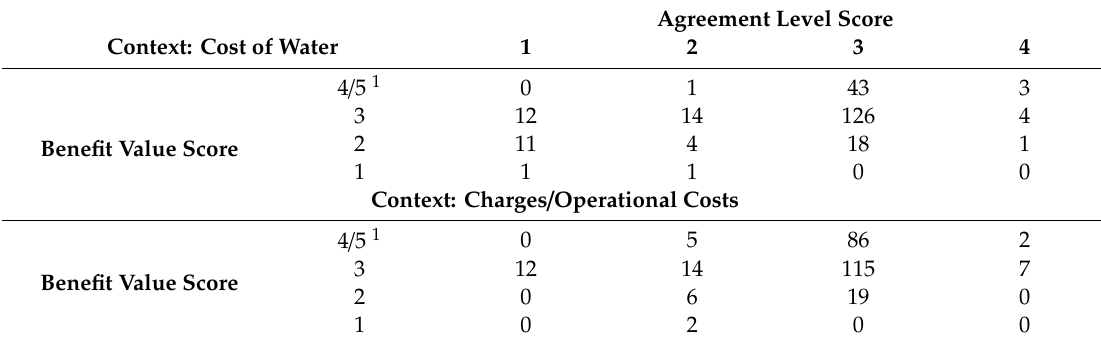
Table 7. Number of benefit value scores by agreement level scores for quantified answers.